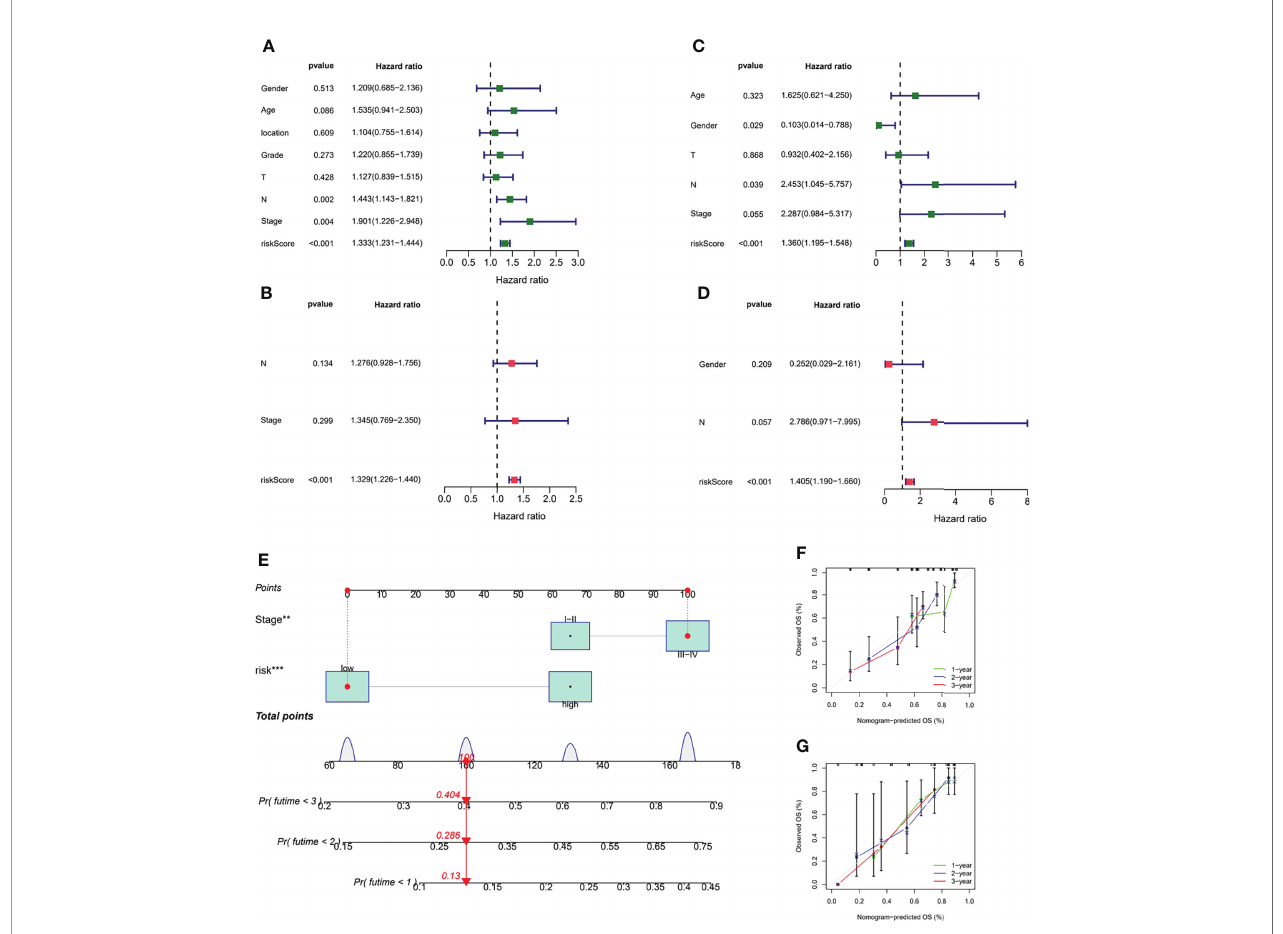
FIGURE 7 | Validation of the m7G-LPS and construction of the nomogram. The univariate Cox forest map of risk score and clinical features in the GEO cohort (A) and TCGA cohort (C) . The multivariate Cox forest plot of risk score and clinical characteristics in the GEO cohort (B) and TCGA cohort (D) . (E) Construction of the nomogram based on risk score and stage. Calibration plots of the nomogram for the prediction of overall survival at 1, 2, and 3 years in the GEO cohort (F) and TCGA cohort (G) . ** P < 0.01, *** P <